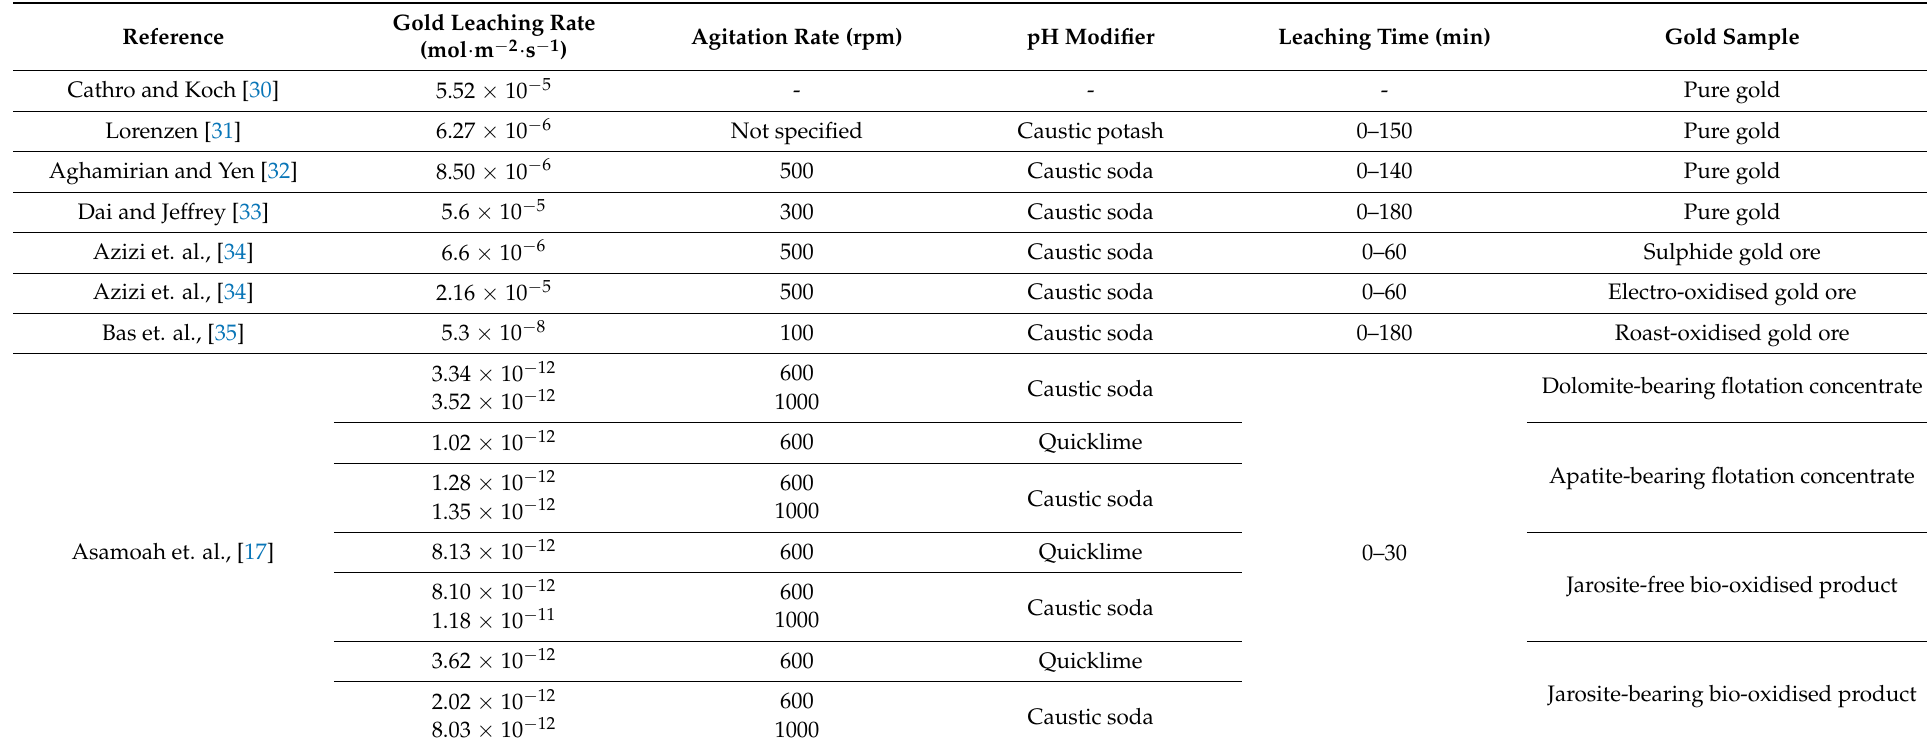
Table 3. Gold leaching rate comparison for selected